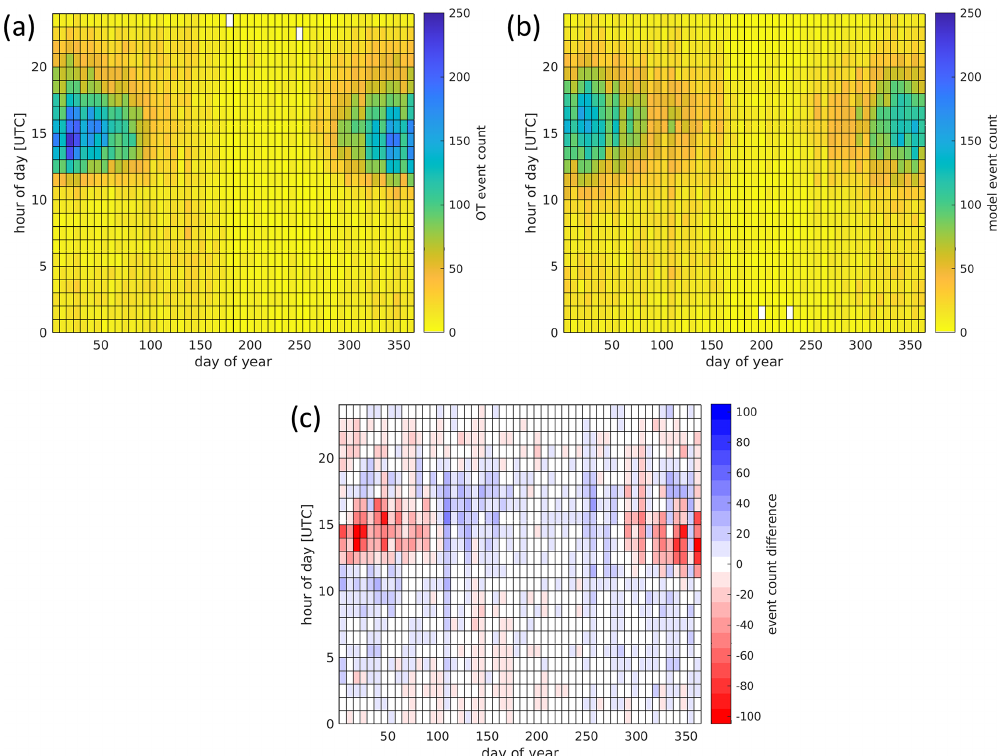
Figure 9. Distribution of potential hail events in the time of day and day of year: (a) historic events from 2005–2018, (b) stochastic model events, and (c) difference between the two for the events shown in Fig. 8. Days of the year are counted from 1 January. The grid shown in all figures represents 1h and